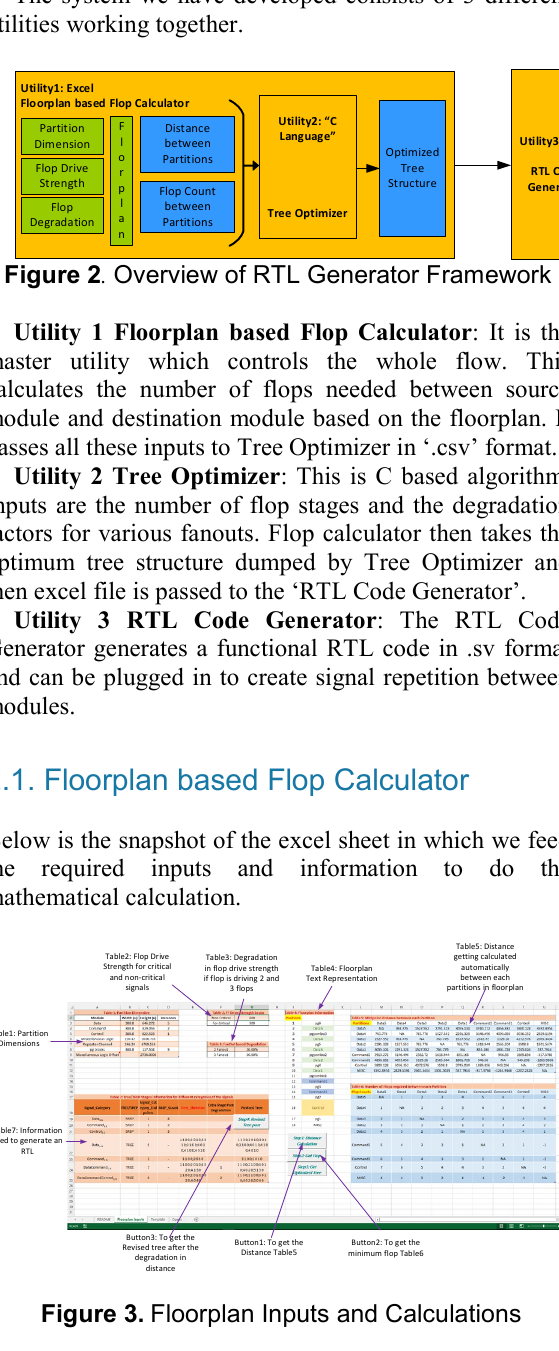
Table6Button3: To get the Button1: To get the Revised tree after the Distance Table5 Button2: To get the minimum flop degradation in distance Figure 3. Floorplan Inputs and